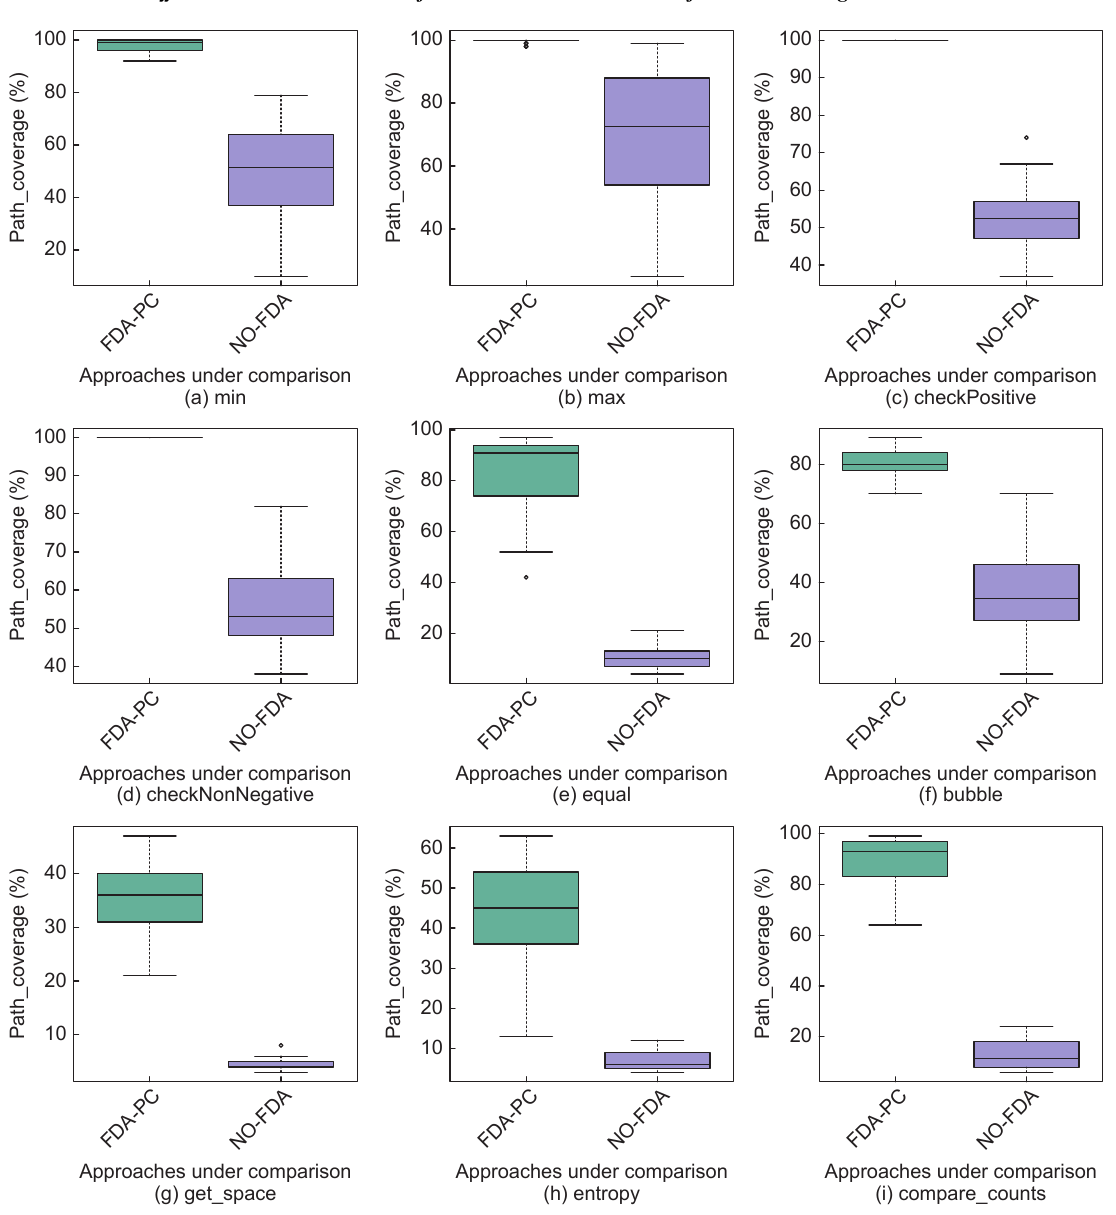
Fig. 7 Box plots for min, max, checkPositive, checkNonNegative, equal, bubble, get_space, entropy, and